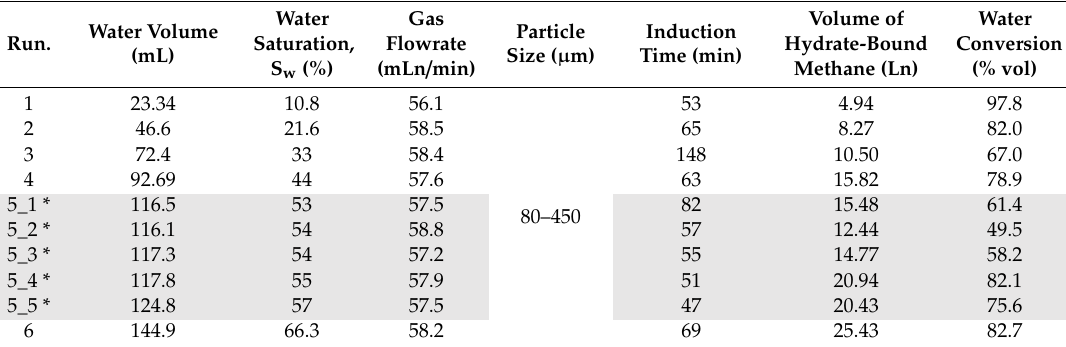
Table 3. Key measured parameters related to methane hydrate formation and dissociation experiments with varied water saturation